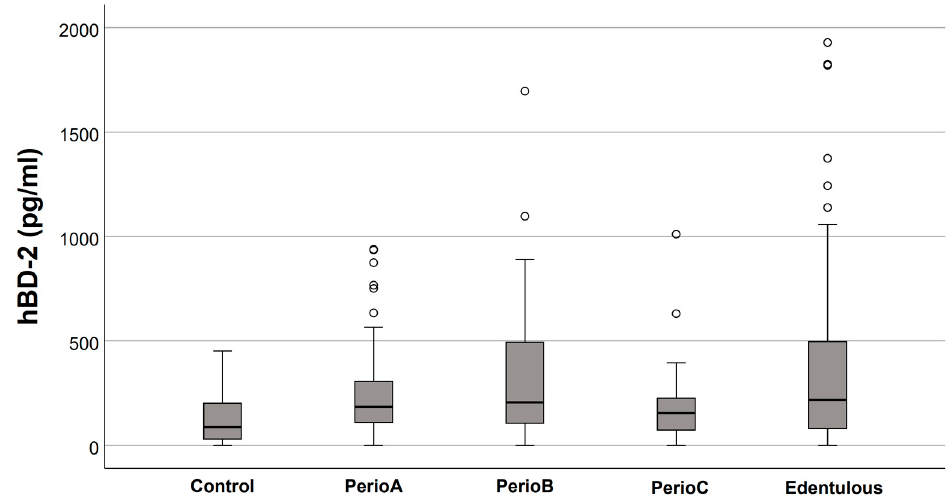
Figure 2. Salivary human β -defensin (hBD)-1 levels in relation to the extent of periodontal destruc- tion (empty circles indicate outliers). No significant differences were found between the groups.